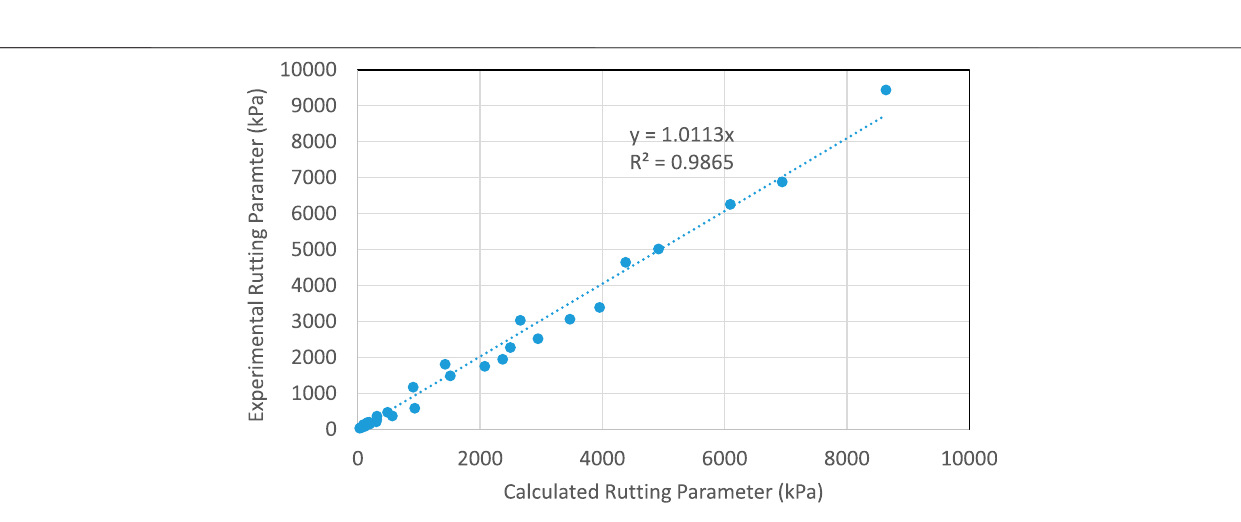
Frontiers in Built Environment |